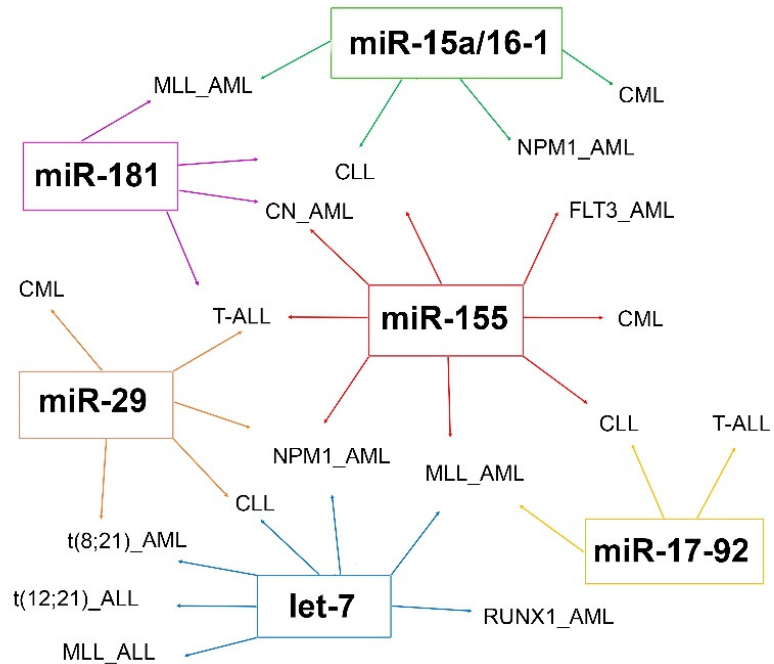
Figure 2. Most frequent miRNAs showing dysregulated expression in myeloid or lymphoid leuke- mia.